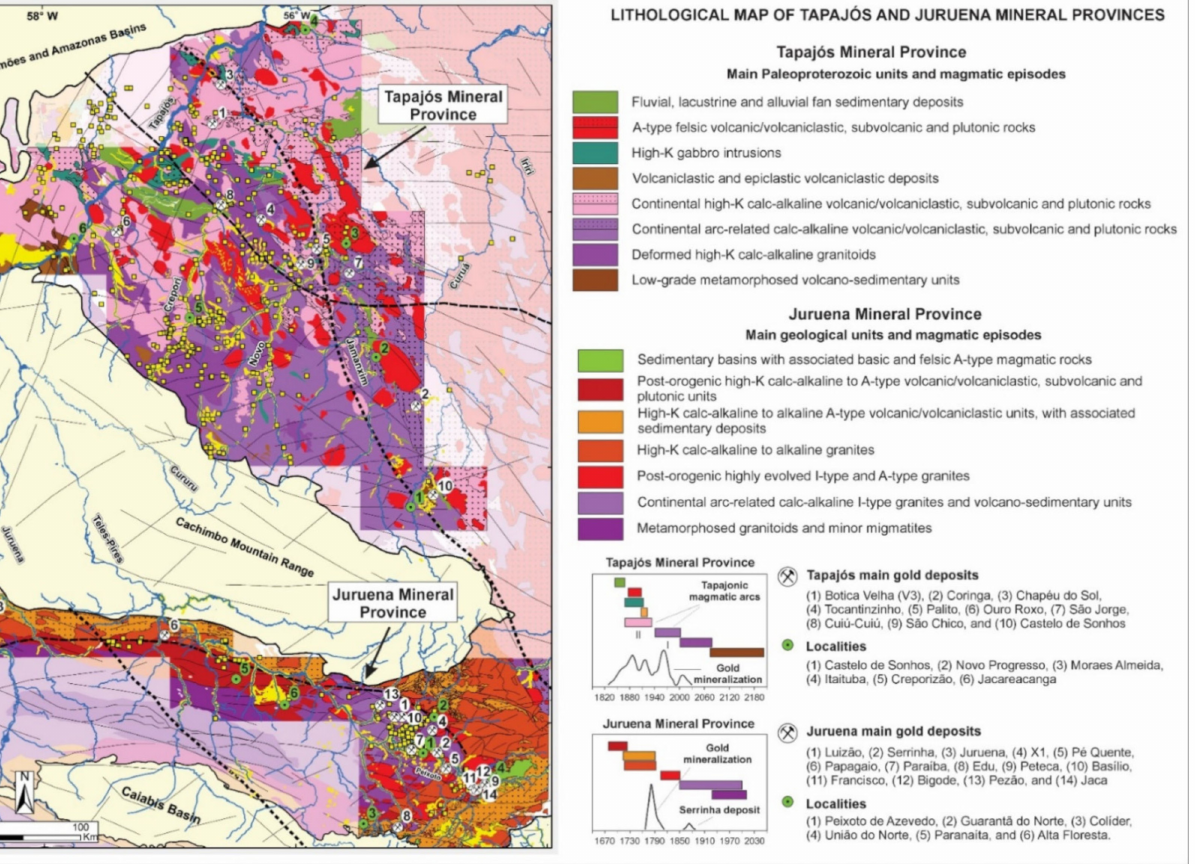
Figure 2. Lithological map of the Tapaj ó s and Juruena mineral provinces in the Amazonian Craton, showing the location of the main gold deposits and occurrences, main magmatic events and gold mineralization. Yellow-filled squares represent gold occurrences, green-filled squares the copper occurrences, short trace lines limit the Tapaj ó s Province of [5], and the long traces limit of [43]. Light-color geologic base map by [45], detailed lithologic map of TMP of [61] and the JMP map by